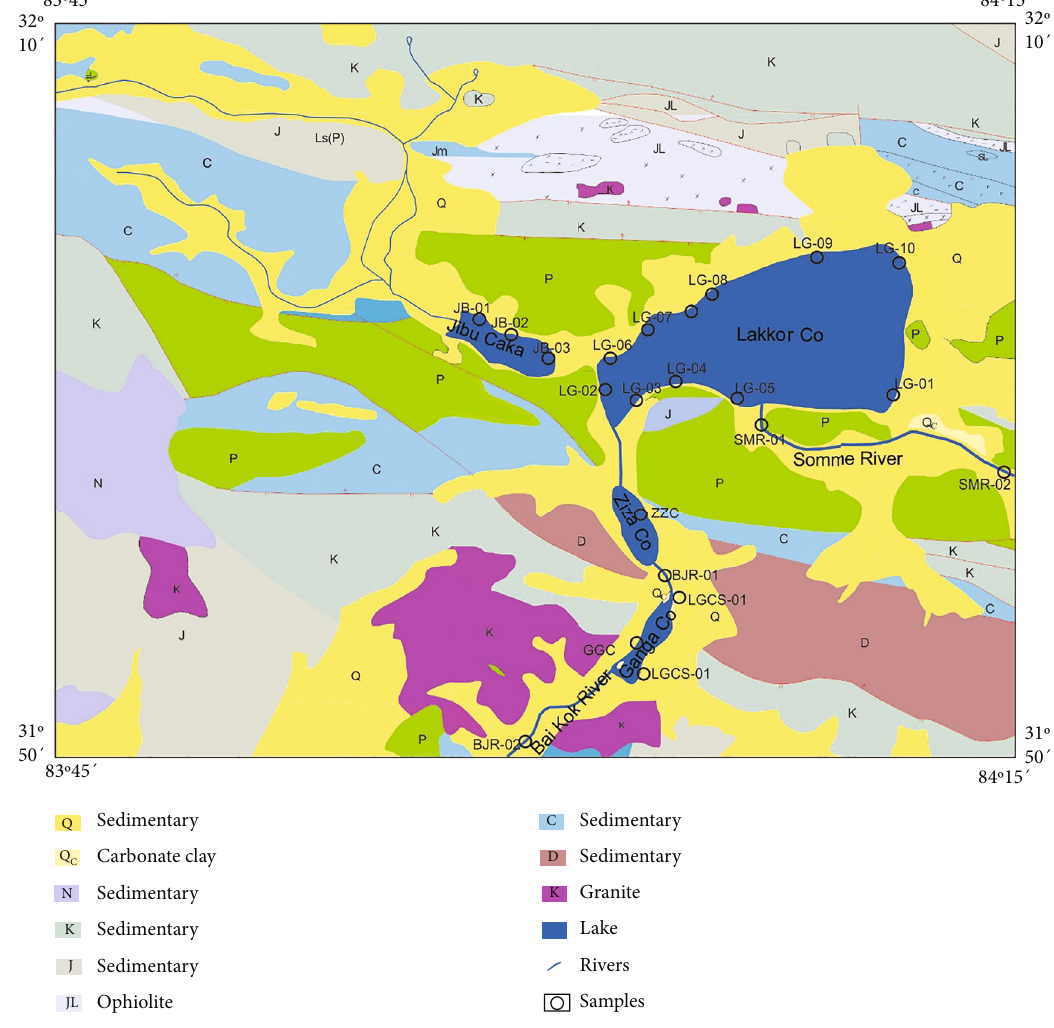
Figure 2: Geological overview of the Lakkor Co area and sampling location map (modi fi ed from Dong et al.